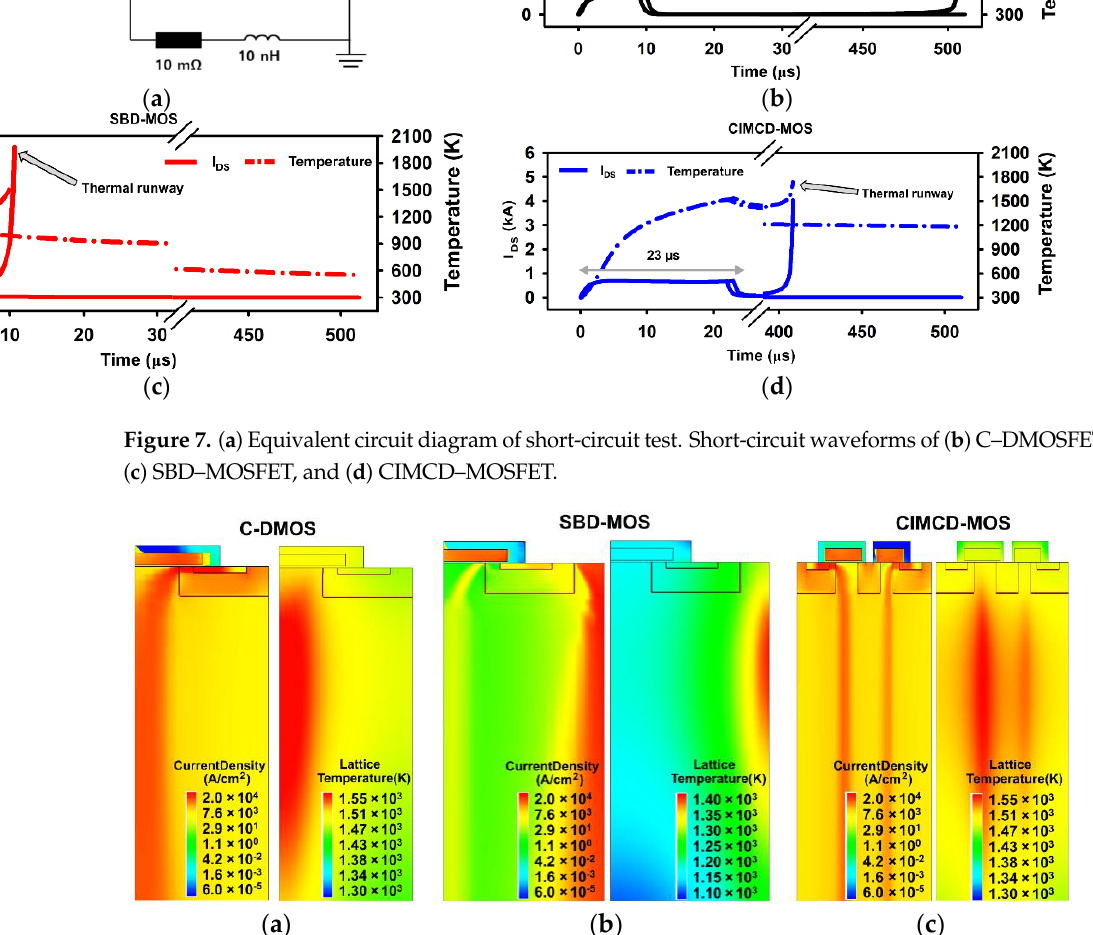
Figure 8. Total current density distribution and lattice temperature distribution at the SC thermal runaway point (@I DS = 1 kA/cm2) of ( a ) C – DMOSFET ( b ) SBD – MOSFET, and ( c ) CIMCD – MOSFET.